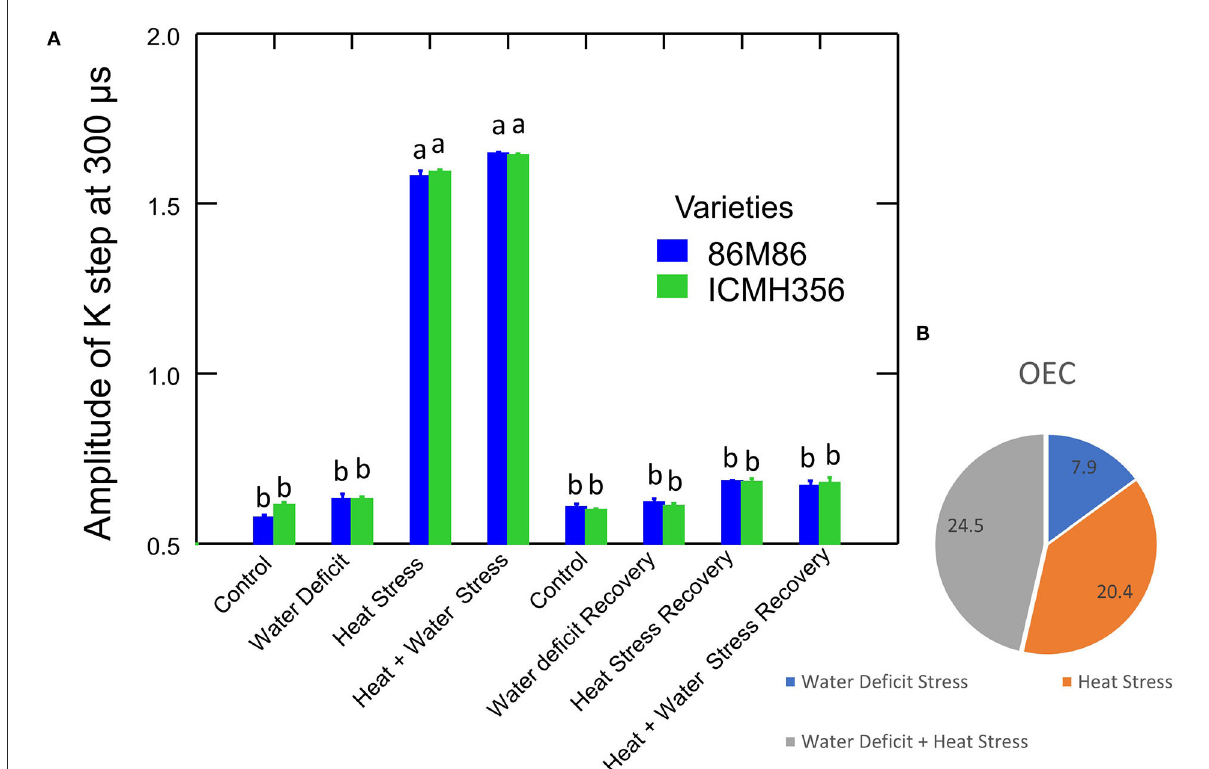
FIGURE4 Amplitude of K-step 300 µ s (WK = VK/VJ value) in two varieties of pearl millet under recovery from water-deficit stress and heat stress in isolation and in combination. The bar represents SE. Letters indicate significance at 0.05, and different letters indicate significant difference between treatments (A) Oxygen-Evolving Complex (OEC) reduced in stress treatments over control [(1–VK/VJ) stress/control] expressed in percentage (B)